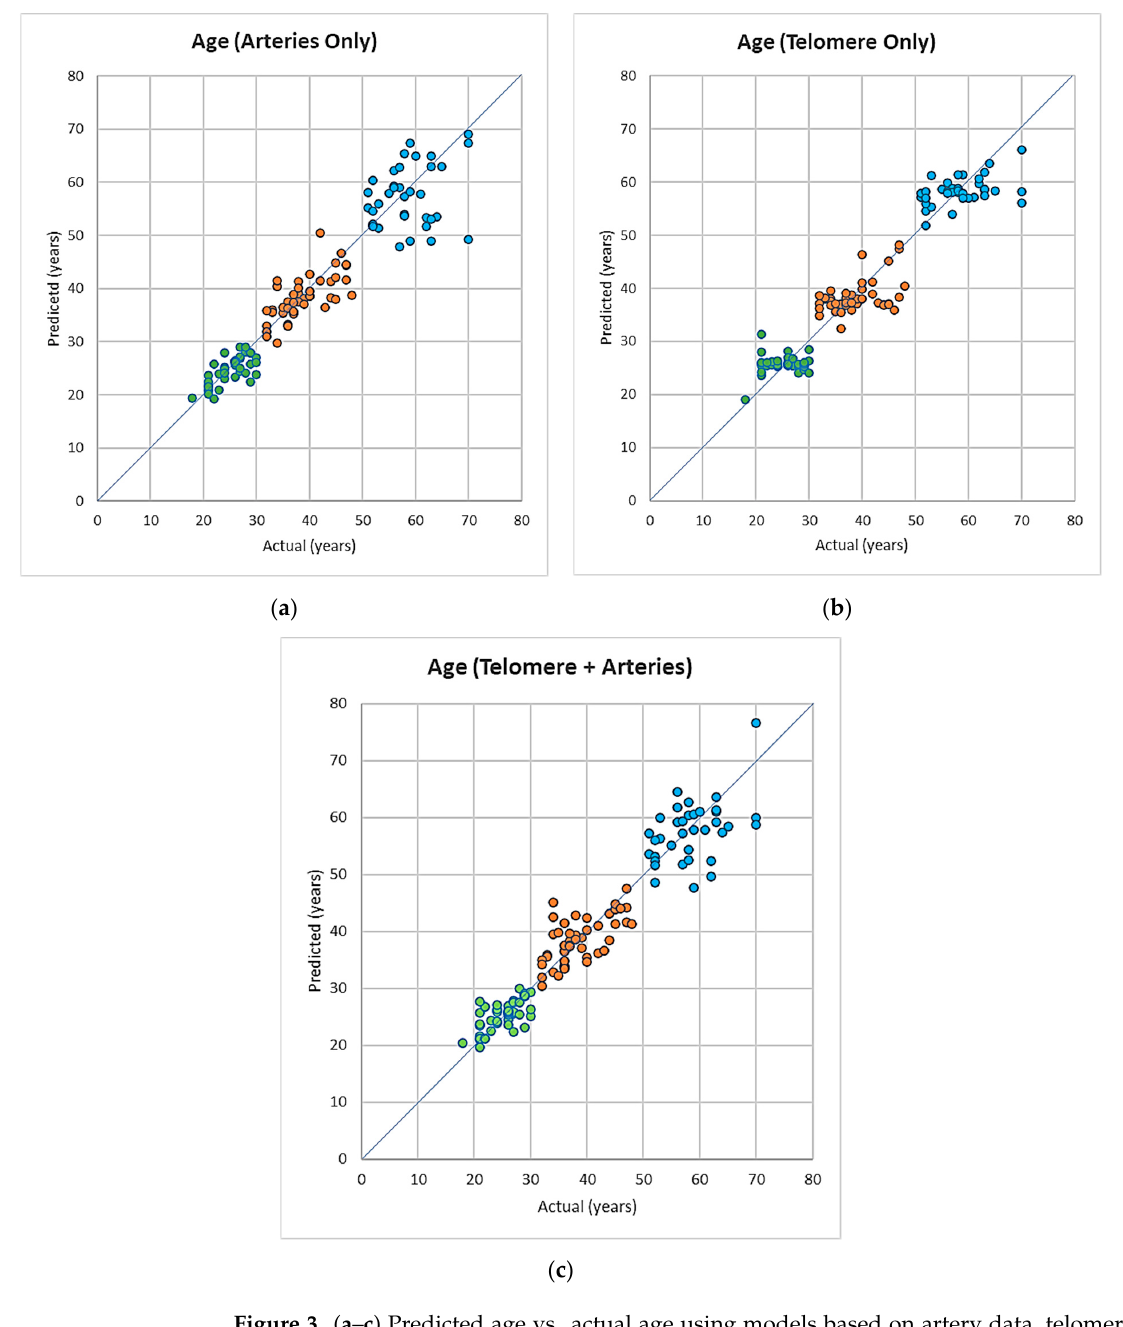
Figure 3. ( a – c ) Predicted age vs. actual age using models based on artery data, telomere relative expression and artery and telomere combined data, colour coded for the different age groups (green: 18–30, orange: 31–50, blue: 50+).